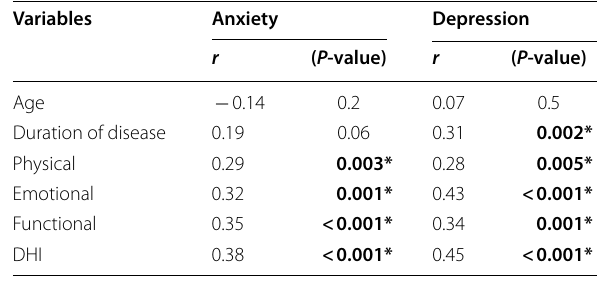
Table 4 Comparisons of HADS scores and clinical diagnosis of vertigo Groups